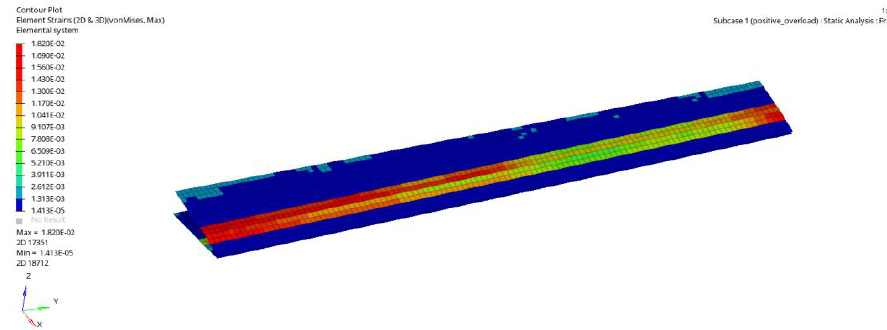
Figure 18. Strain of flexible skin ( “ +2.5 G ” in condition A).